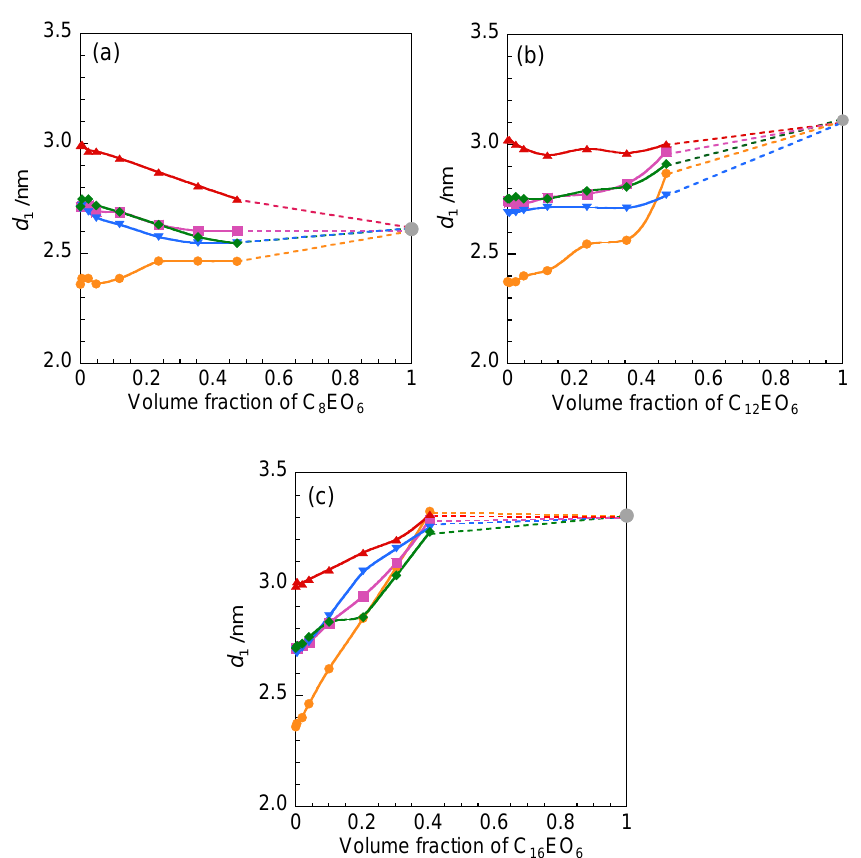
Figure 2. Surface tension as a function of the volume fraction of C 12 EO 6 in amphiphilic gemini ionic Figure 7. Variation in layer spacing d 1 with the volume fraction of ( a ) C 8 EO 6 , ( b ) C 12 EO 6 , and ( c ) C 16 EO 6 liquids at 25 °C: 2C 10 (2-O-2) NTf 2 (orange ●), 2C 12 (2-O-2) NTf 2 (pink ■ ), 2C 14 (2-O-2) NTf 2 (40 °C, red in 2C n (Spacer) NTf 2 at 25 ◦ C: 2C 10 (2-O-2) NTf 2 (orange • ), 2C 12 (2-O-2) NTf 2 (pink (cid:4) ), 2C 14 (2-O-2) NTf 2 ▲ ), 2C 12 (2-N-2) NTf 2 (blue ▼ ), and 2C 12 (2/2-N-2) NTf 2 (30 °C, green ◆ ). (40 ◦ C, red (cid:78) ), 2C 12 (2-N-2) NTf 2 (blue (cid:72) ), and 2C 12 (2 / 2-N-2) NTf 2 (30 ◦ C, green